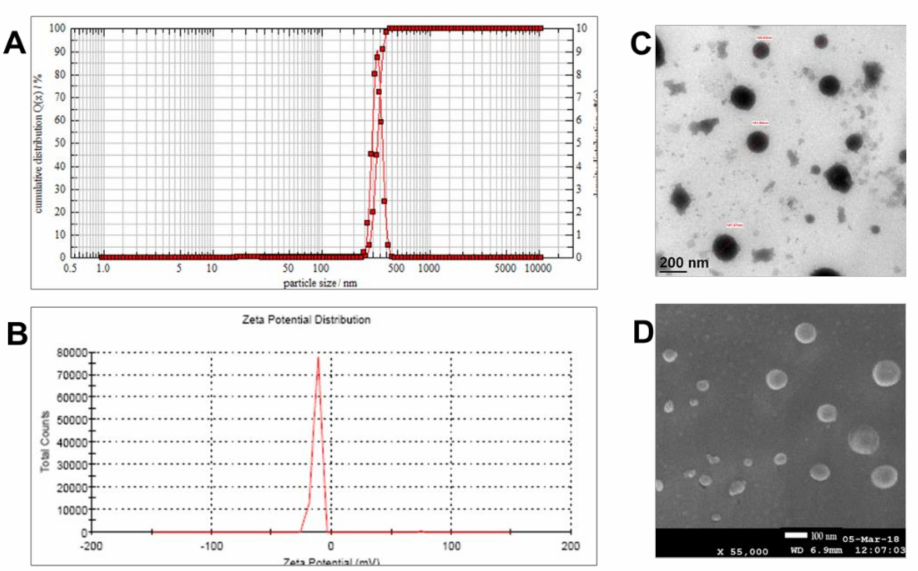
Figure 3. ( A ) Particle size analysis by photon cross-correlation spectroscopy, ( B ) zeta potential, ( C ) transmission electron micrograph (scale bar = 200 nm), and ( D ) scanning electron microscopy (scale bar = 100 nm) image of nano-emulsion of the sesame-oil extract of turmeric.